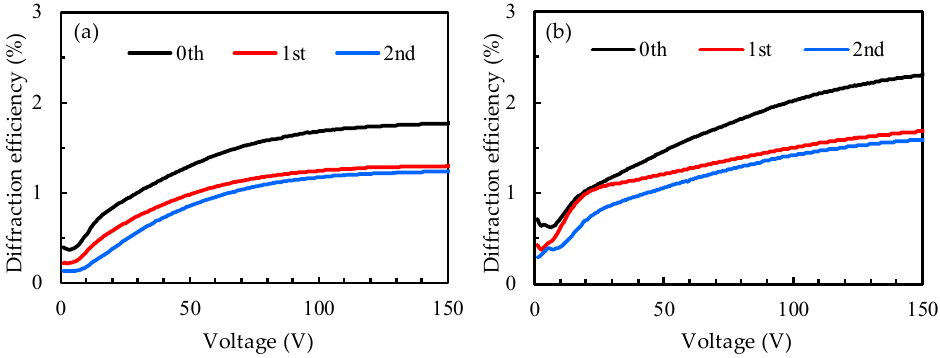
Figure 6. Diffraction efficiency of PDLC grating with an IPS electrode design of a line width and space width of ( a ) 15 μ m and 15 μ m, and of ( b ) 10 μ m and 10 μ m.